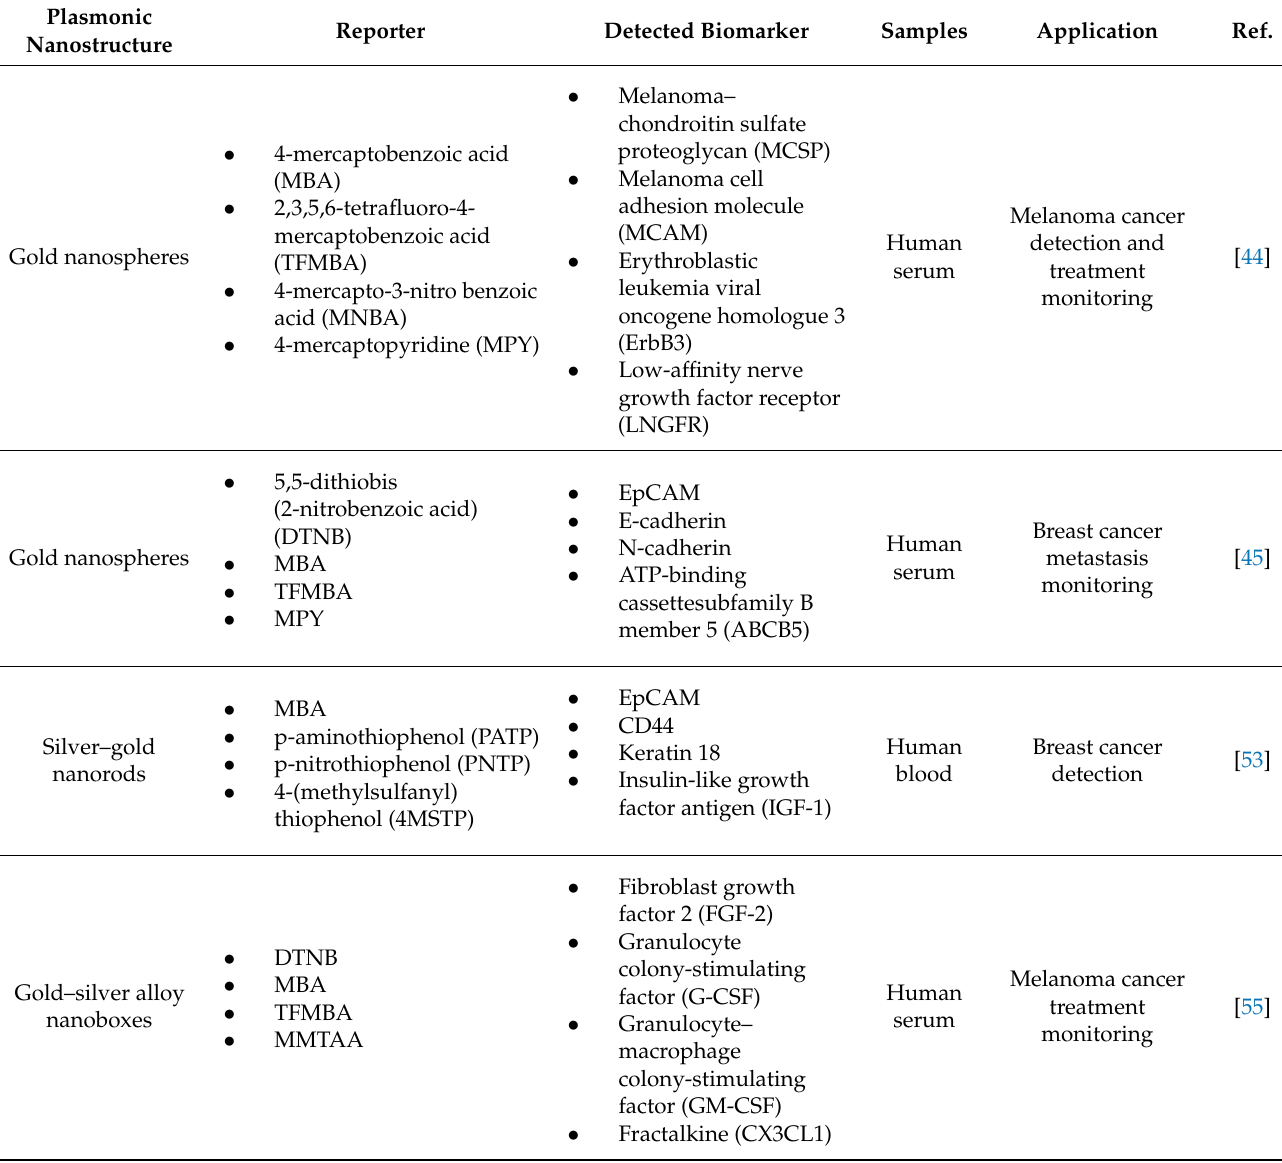
Table 2. Representative SERS nanotags in circulating biomarker detection. Reporter Detected Biomarker Samples Application